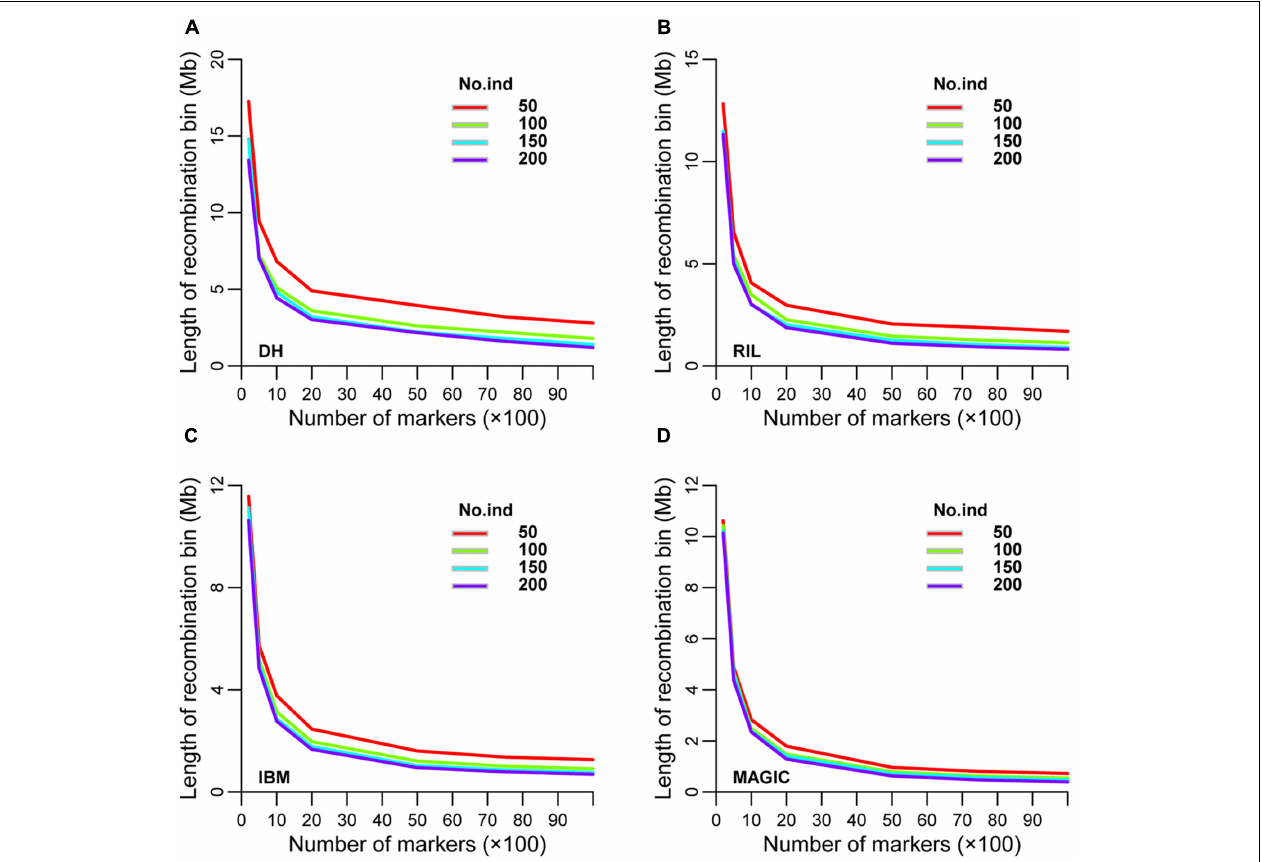
FIGURE 4 | Prediction of recombination bin length in four types of population. Variation of recombination bin length among different densities of markers and numbers of lines in (A) DH, (B) RIL, (C) IBM, and (D) MAGIC population(s). DH, double haploid; RIL, recombination inbred lines; IBM, intermated B73xMo17; MAGIC, multi-parent advanced generation